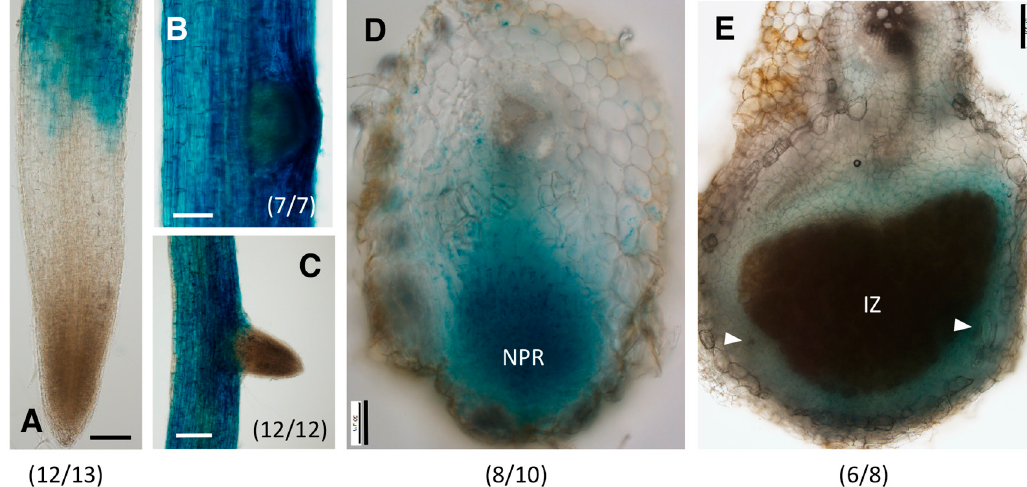
Figure 4. Expression patterns of GmGH3-14p:GUS in soybean roots and nodules. ( A – C ) Expression of GmGH3-14p:GUS in ( A ) root tips, ( B ) mature root region with a lateral root primordium, and ( C ) mature root region with a young lateral root; ( D , E ) Expression of GmGH3-14p:GUS in ( D ) emerging nodule (transverse section at 10 dpi), and ( E ) mature nodule (transverse section at 17 dpi). NPR- nodule primordium; IZ–infection zone; Arrowheads indicate nodule vascular bundles. The number of independent transgenic roots/nodules showing the representative staining pattern out of the number of roots/nodules examined is indicated in each panel. Scale bars: ( A , B , E ) 100 μ m; ( C ) 200 μ m; ( D ) 50 μ m.